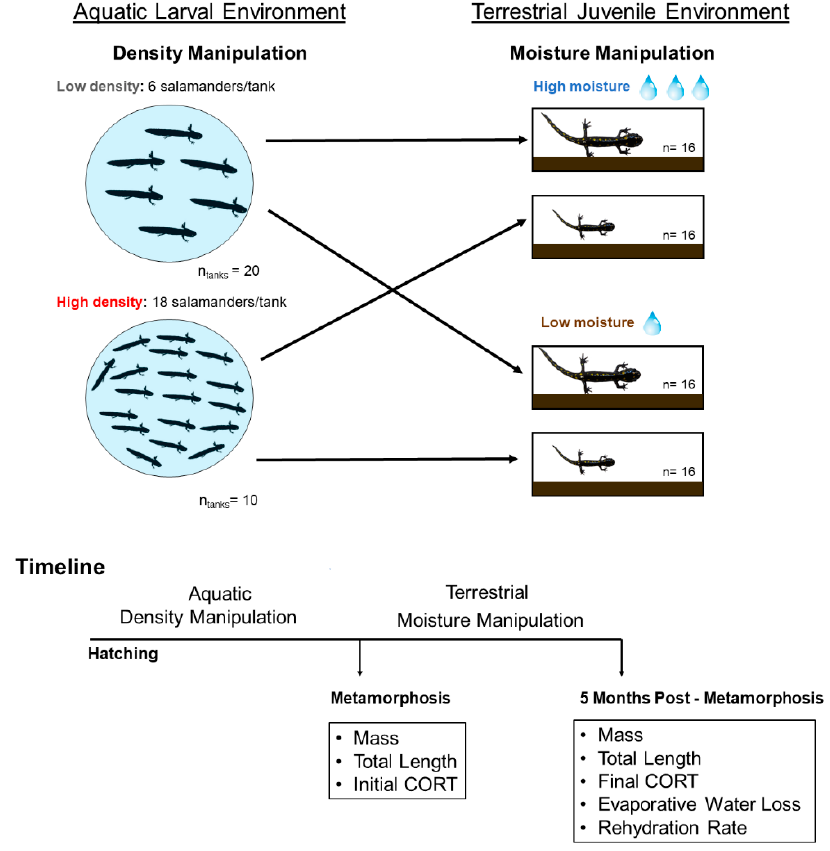
Figure 1. Experimental design illustrating the treatments applied in the aquatic and terrestrial portions of the A. maculatum life cycle and the dependent variables measured at two time points in the experiment.